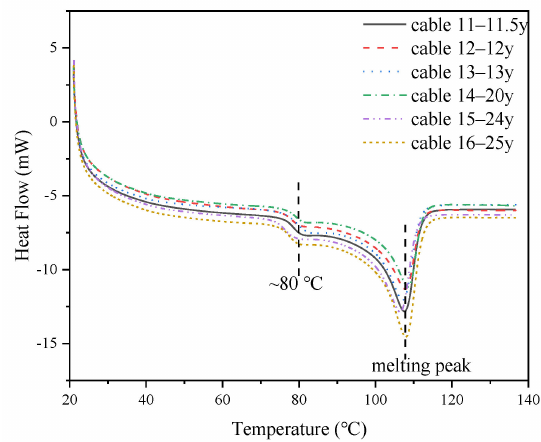
Figure 1. DSC results of XLPE films from cables with different service